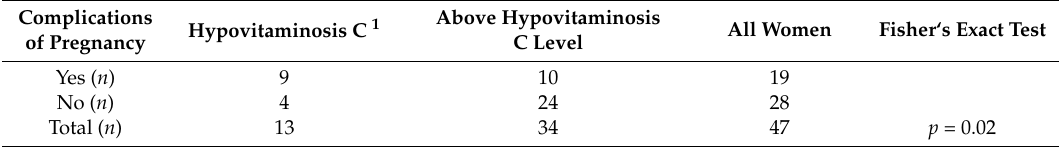
Table 3. Women with complications in subgroups according to vitC status in late